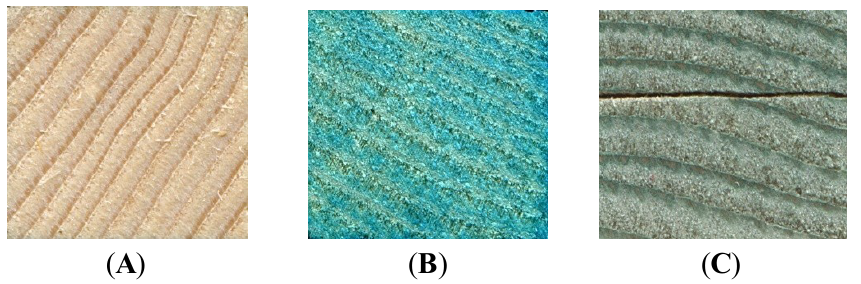
Figure 1. Coloring of external surface of test blocks. ( A ) Noble fir with no treatment; ( B ) aniline dye carried in ethanol on noble fir; ( C ) wood-agar colorant carried in dichloromethane (DCM) from C. aeruginosa on noble fir.